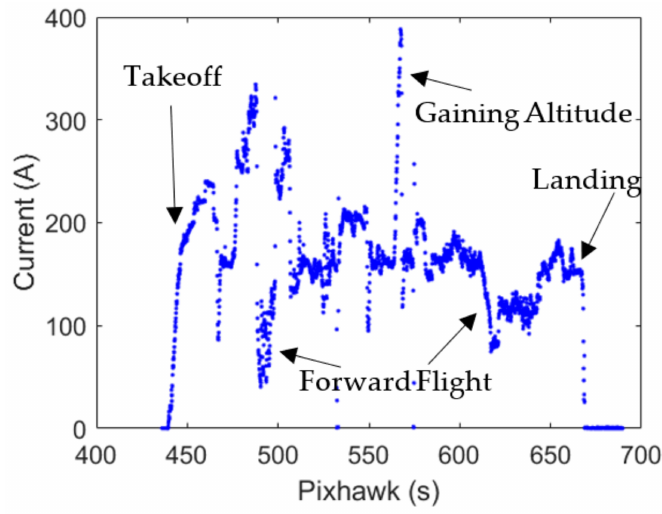
Figure 5. Current over the course of the